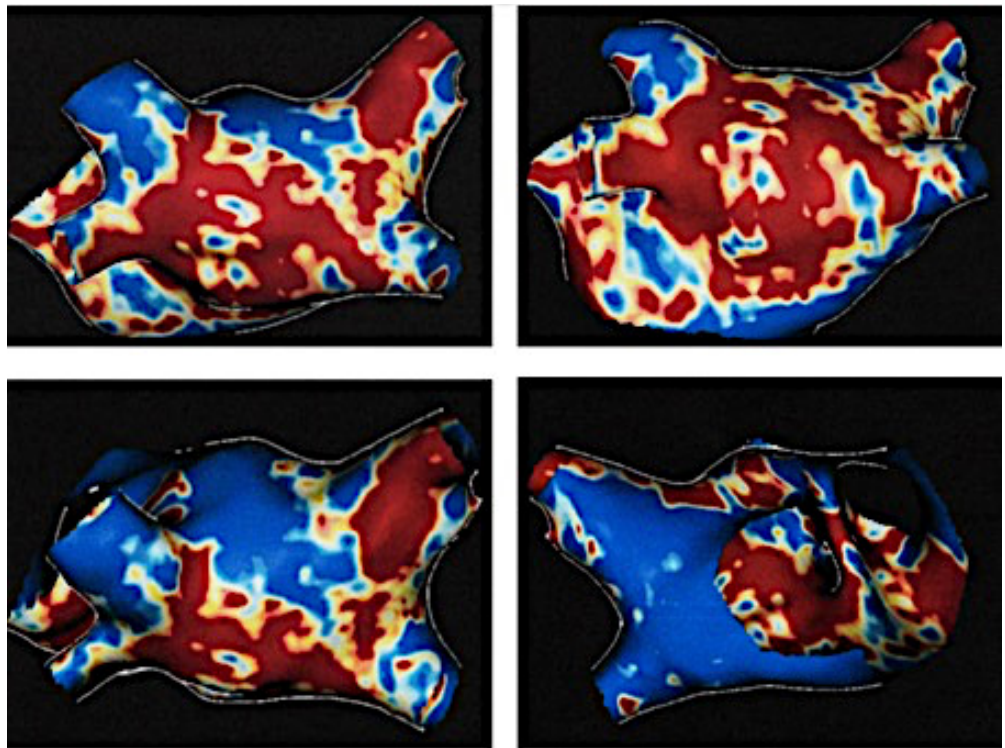
Figure 2. LGE-LA of 35.4% (Utah IV) in a persistent AF patient with repetitive ablations. Increased fibrosis at the posterior wall and pulmonary veins. Red demonstrates the presence of fibrosis. AF: atrial fibrillation; LGE-LA- late gadolinium enhancement in the left atrium.